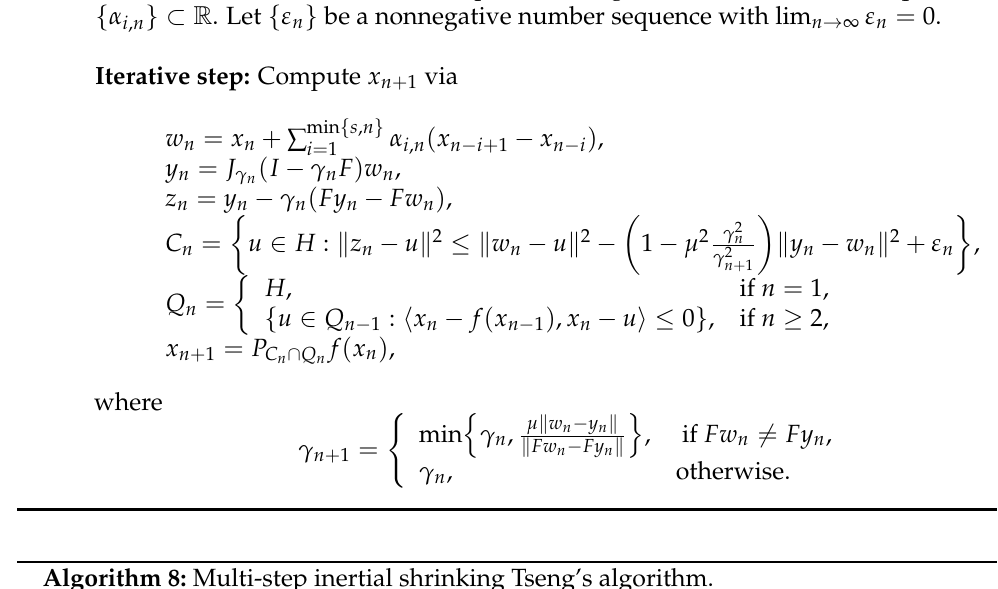
Algorithm 8: Multi-step inertial shrinking Tseng’s